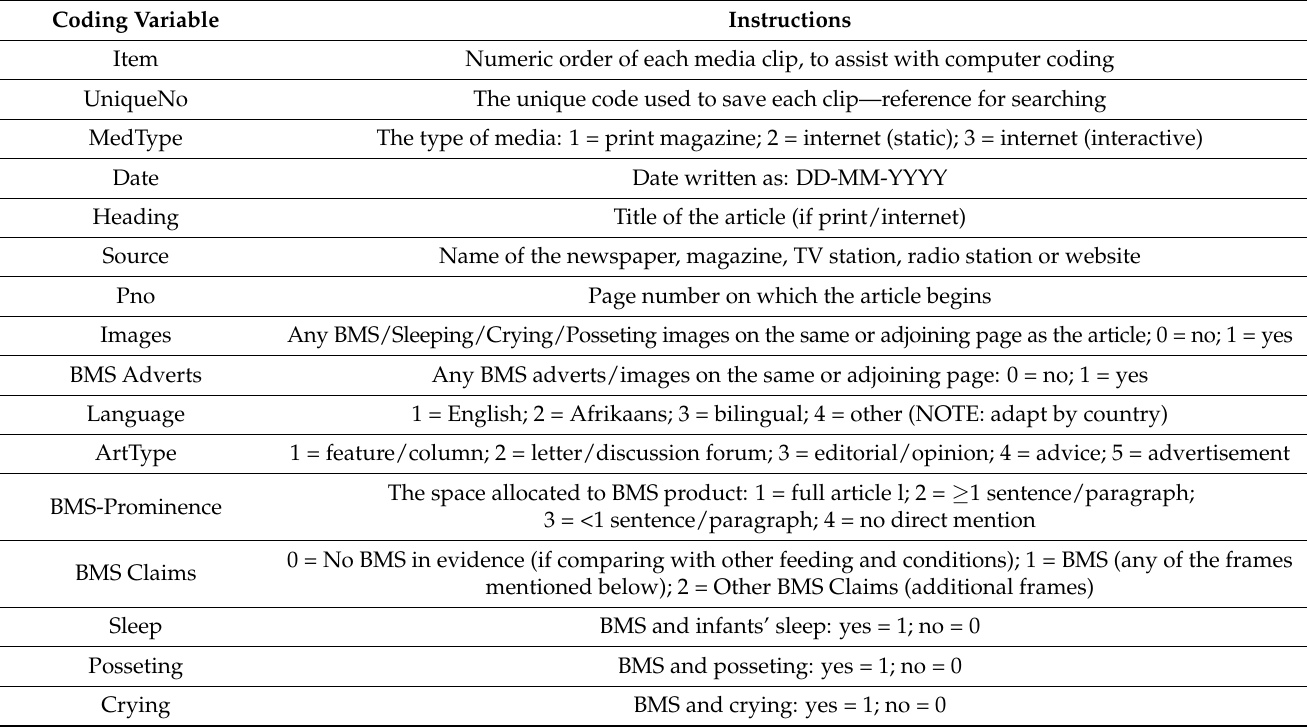
Table A1. Content Coding Framework (also for Use with Other Media